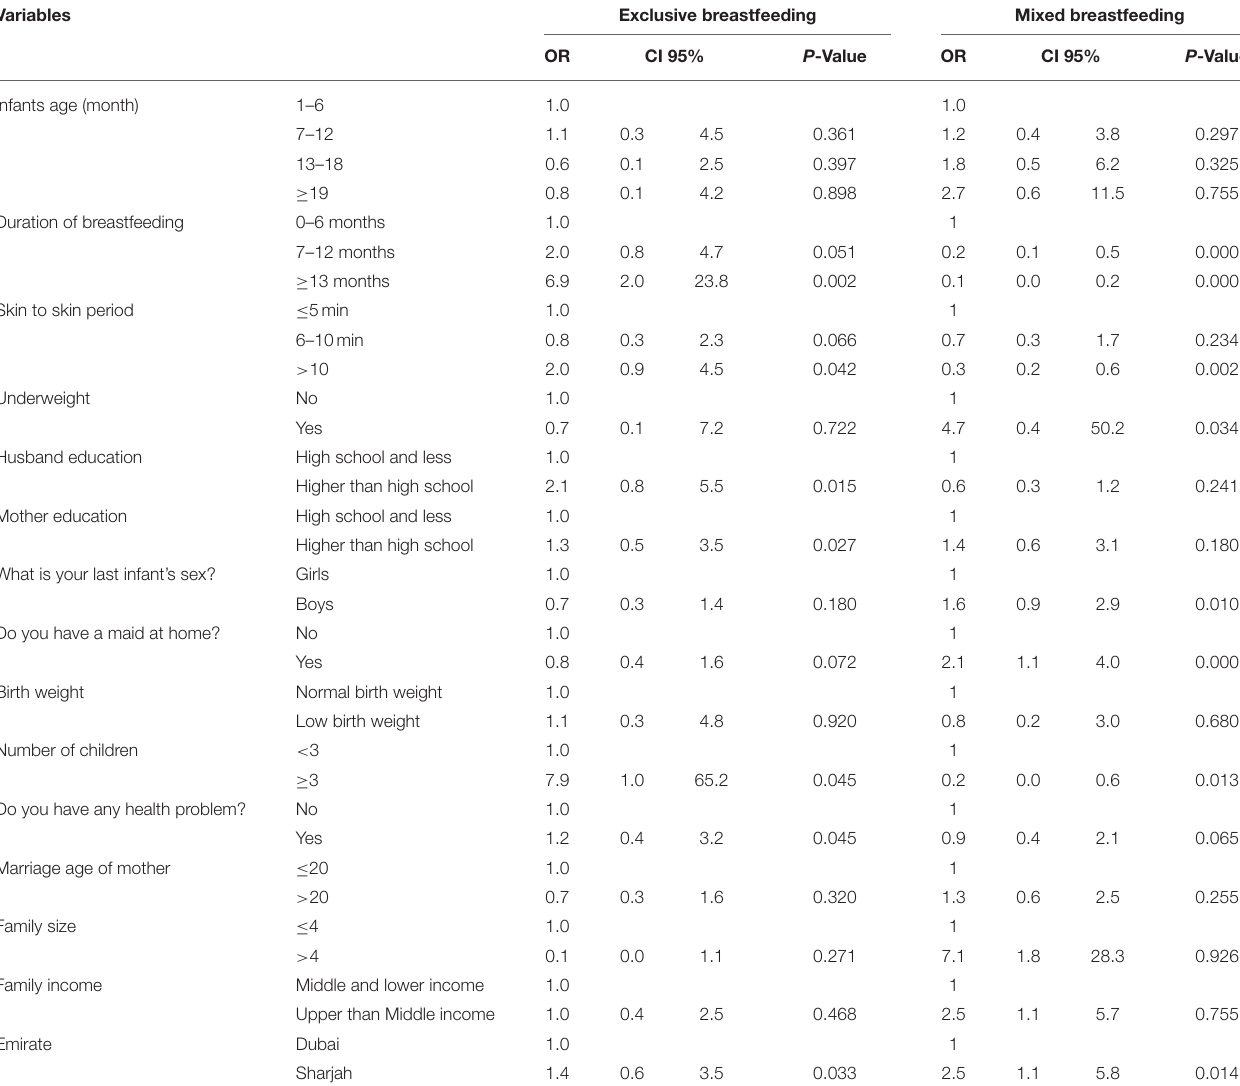
TABLE 7 | Odds ratio between EBF and mixed feeding together with some variables.